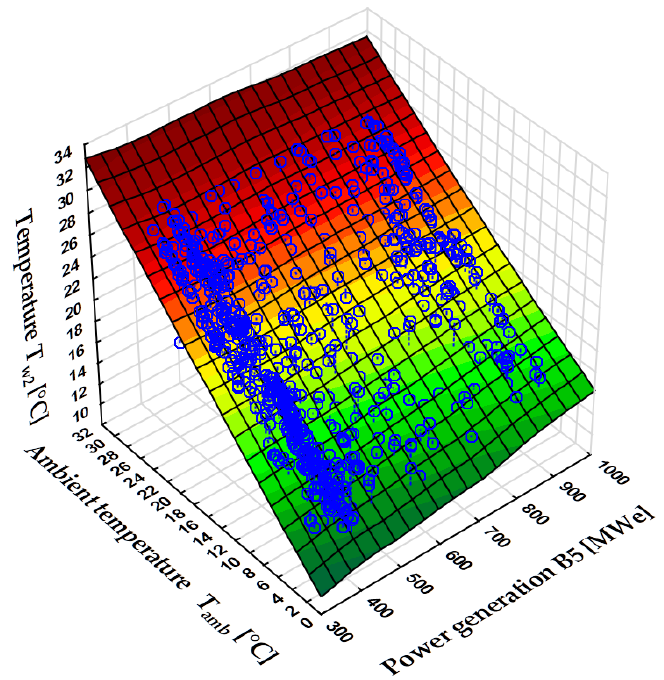
Figure 3. The relationship between the cooled water temperature T w 2 and ambient temperature T amb and power output of power unit no 5 B 5 (for air humidity range of ϕ = 70 ± 5%). Source: own elaboration (Statistica software).